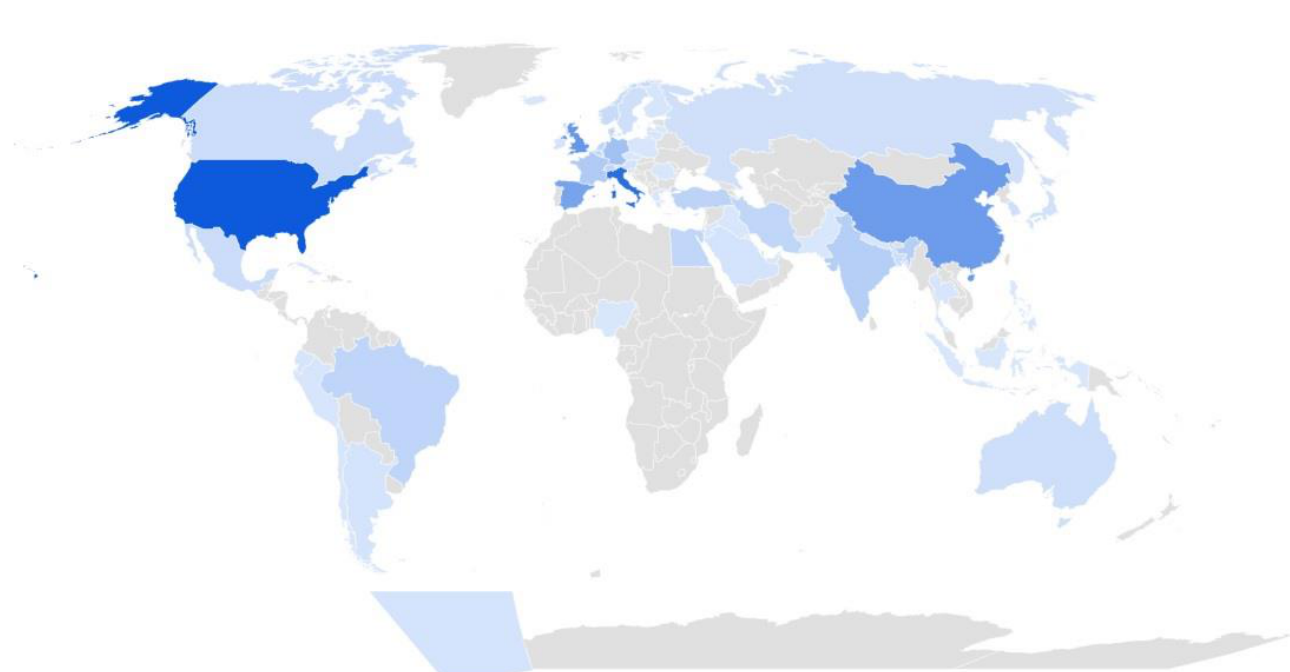
Figure 3. Screenshot (fragment) of an evidence map sorted out by study design, outcomes, and sub- group of adults (red) or children (blue). 4. Discussion 4.1. Main Findings We identified a large body of research on post-COVID-19 conditions. Most of the research included unvaccinated adults with mild-to-critical disease, had a relatively short- term follow-up, and focused on specific health symptoms rather than global functioning and quality of life, highlighting a paucity of research in children and adolescents.